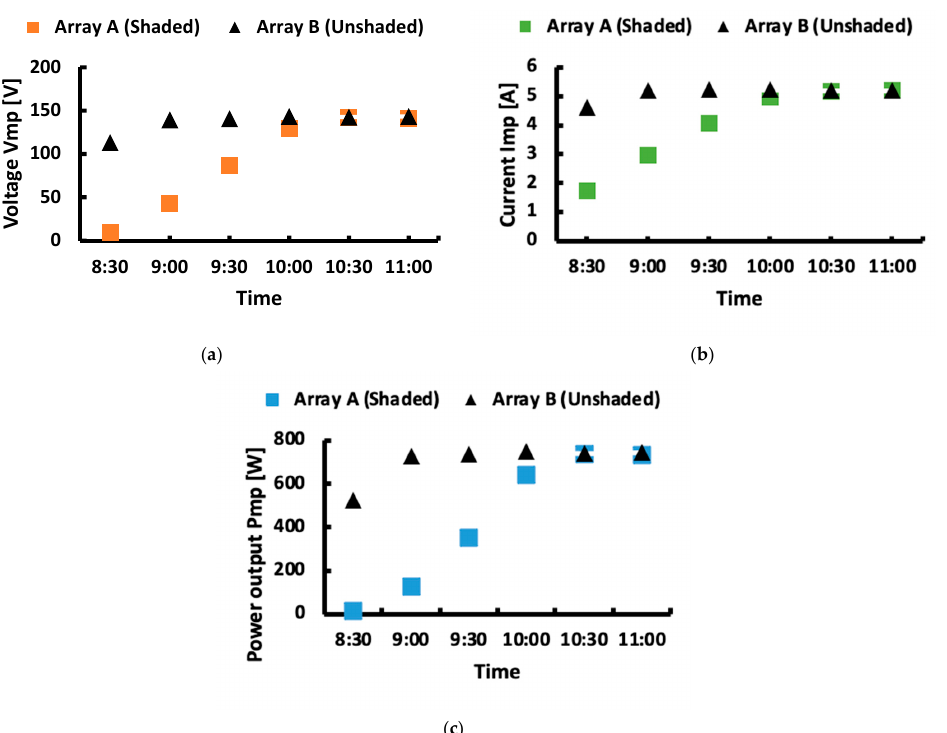
Figure 6. Comparison between array A and array B: ( a ) voltage and time, ( b ) current and time, and ( c ) power output and time. Energies 2021 , 14 , x FOR PEER REVIEW The effect of shading percentage on the first PV cells connected with a bypass diode of the PV modules in array A is shown in Figure 7. The shading percentage changes cor- responding to the direction of the sun from 8:30 to 11:00 a.m. The shading percentage reduces dramatically during this period. When the shading percentage on PV array A increased, the voltage ( 𝑉 (cid:2923)(cid:2926) ) , current ( 𝐼 (cid:2923)(cid:2926) ) , and power output (𝑃 (cid:2923)(cid:2926) ) drops dramatically. It could be recognized that array A power output was inversely proportional to the shad- ing percentage.